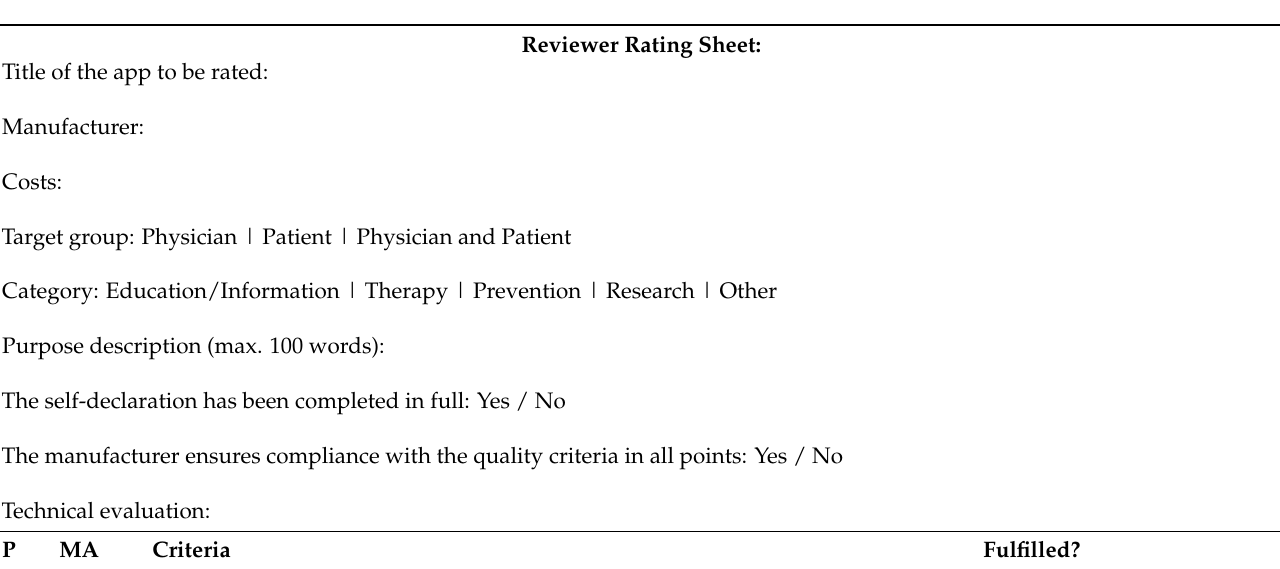
Table 3. Society evaluation sheet: rating sheet for internal assessment through independent internal